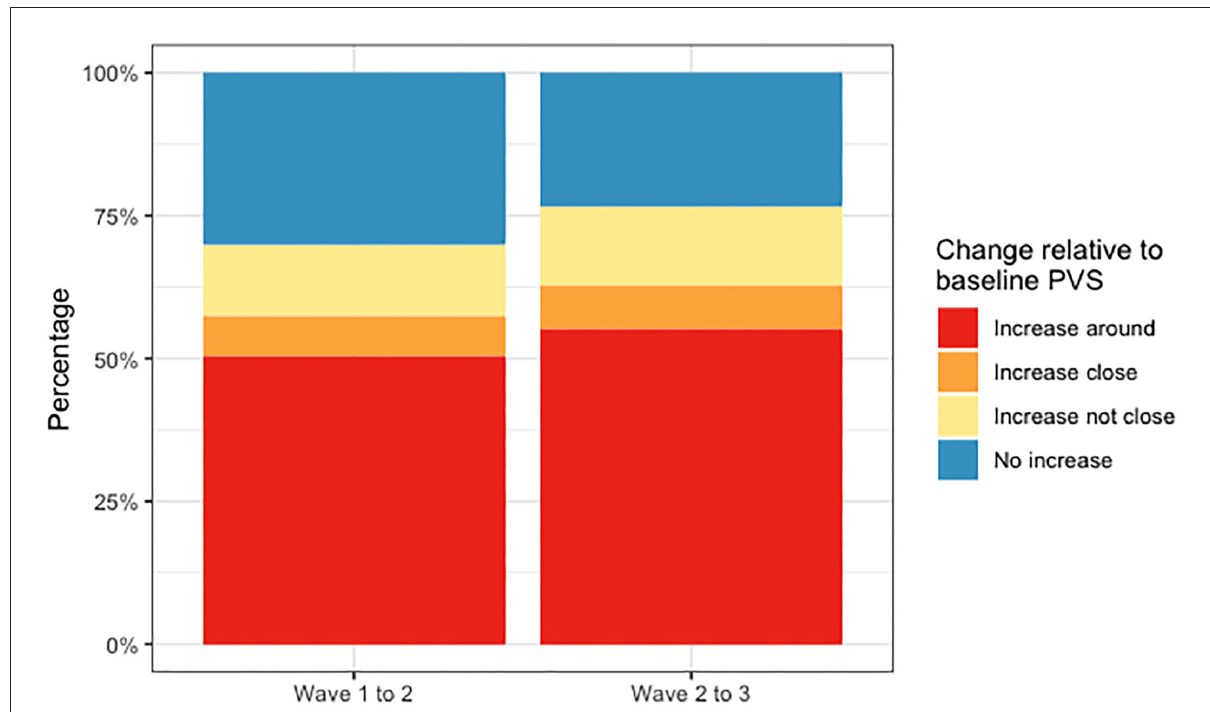
FIGURE9 Percentages of deep WMH that increased around, close and not close to baseline PVS, and did not increase between waves 1 and 2 and waves 2 and 3.